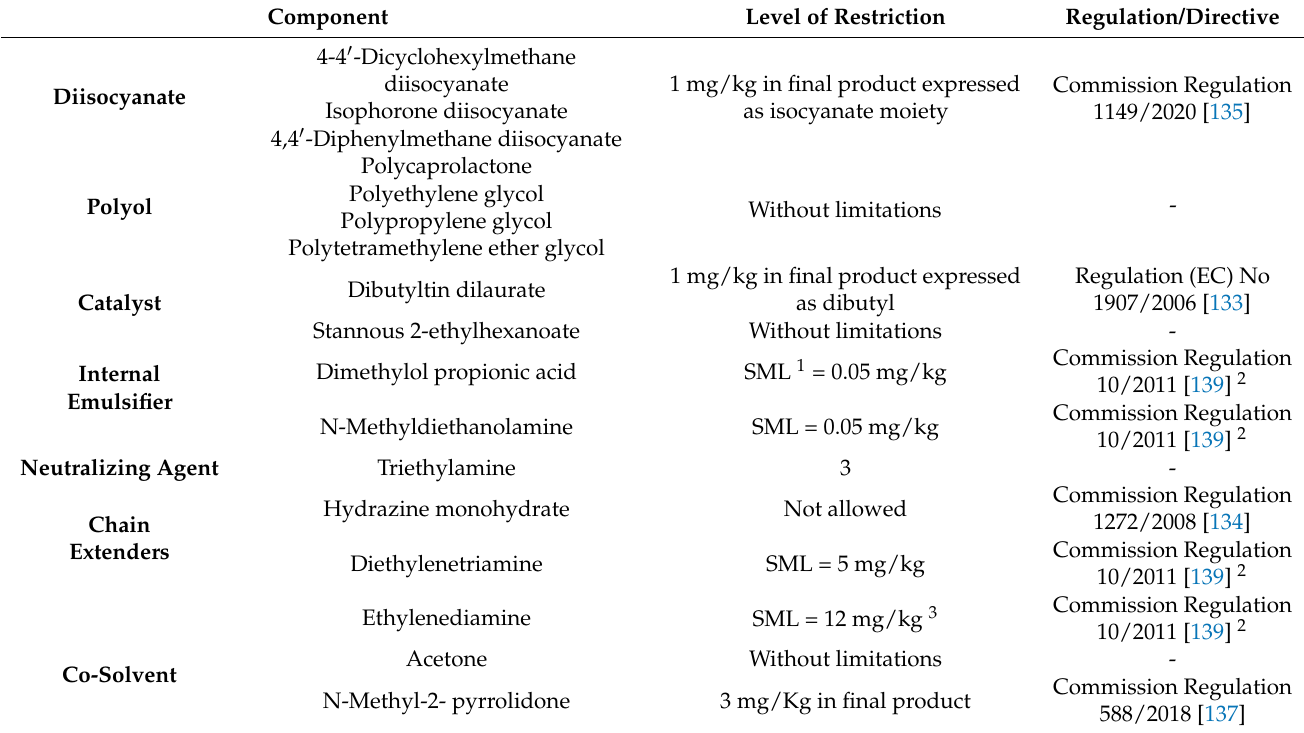
Table 5. Examples of typical WBPU and WBPUU raw materials restrictions and levels according to the actual European